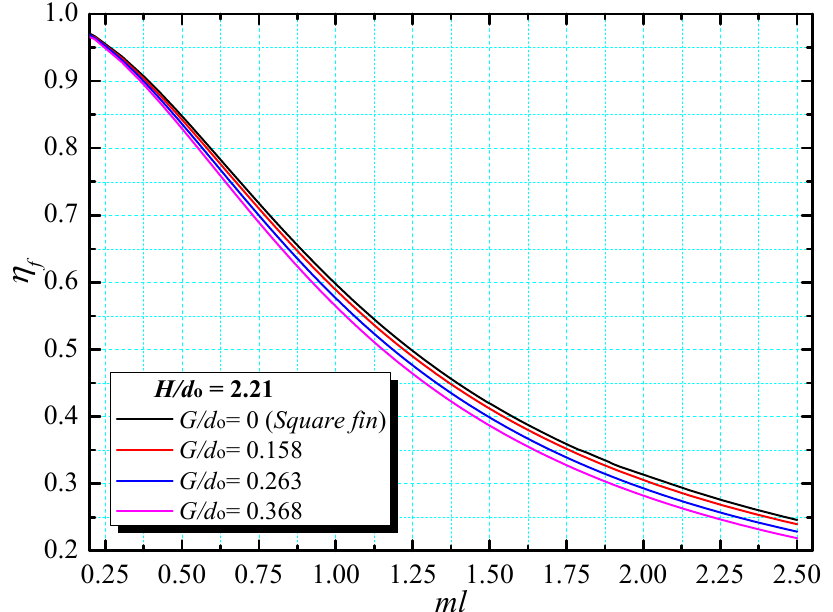
Figure 5. Influence of different G / d o on the fin efficiency of H-type fins when H / d o = 2.21.